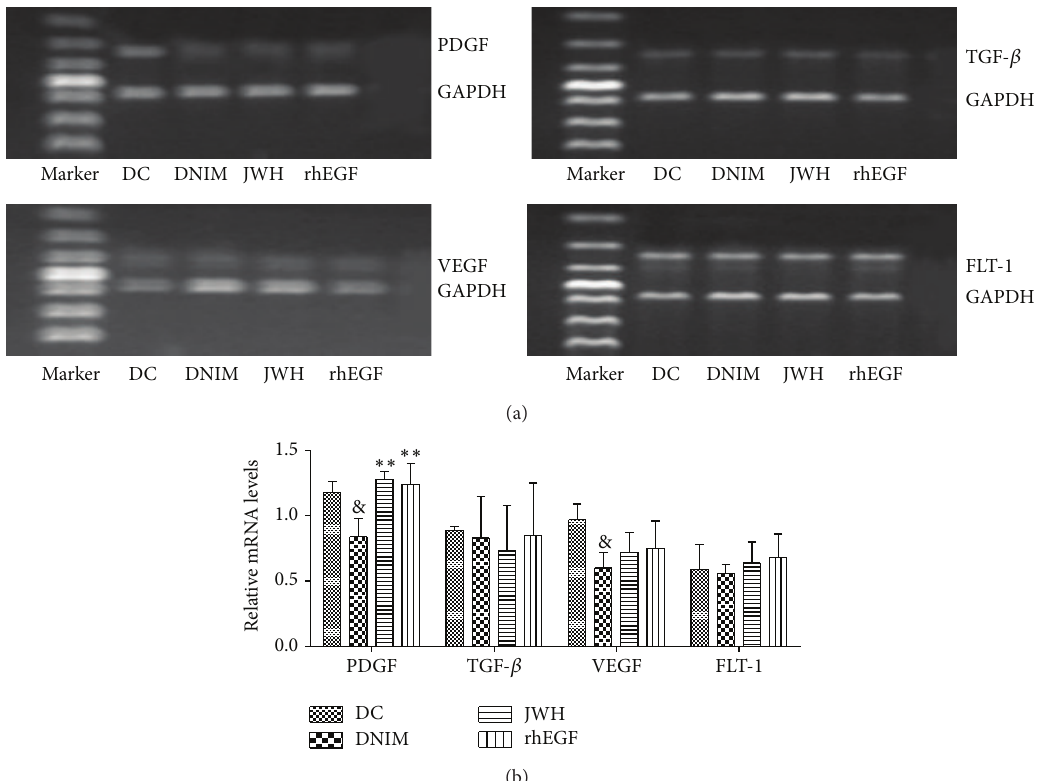
Figure 5: (a) Results of the agarose gel electrophoresis of PDGF, TGF- 𝛽 , VEGF, and FLT-1 mRNA expression. (b) Results of the effects of Jing WanHongointmentonPDGF,TGF- 𝛽 ,VEGF,andFLT-1mRNAexpression.Valuesnormalizedtoglyceraldehyde3-phosphatedehydrogenase (GAPDH) mRNA expression and expressed as mean + SEM ( 𝑥 ± 𝑆 ), & denotes 𝑃 < 0.05 versus DC group; ∗∗ 𝑃 < 0.01 versus DNIM